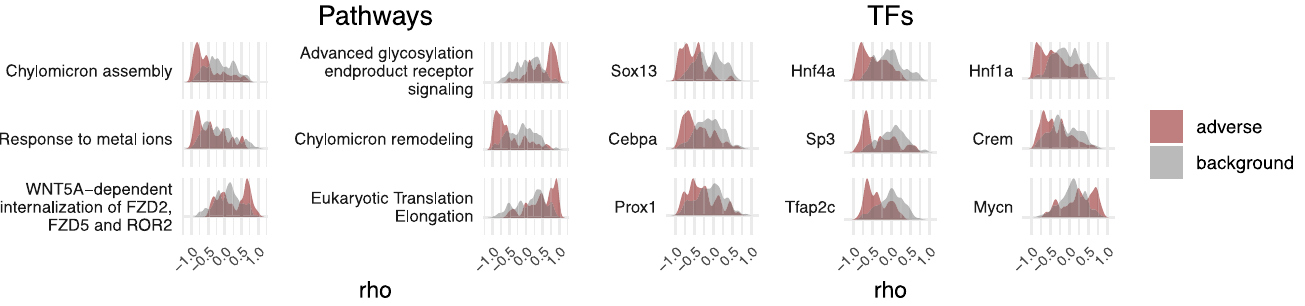
Fig 11. Combining time dependence and concordance to identify mechanistically supported biomarkers. A) The relation between time concordance, quantified by the enrichment p-value for event activation before adverse histopathology, and time dependence, quantified by the meta p-value for Spearman correlation between time and event activation across adverse conditions, is shown. B) For events with the most significant time-dependence, the distribution of correlation coefficients is shown providing further insight into the strength of correlation and consistency across adverse